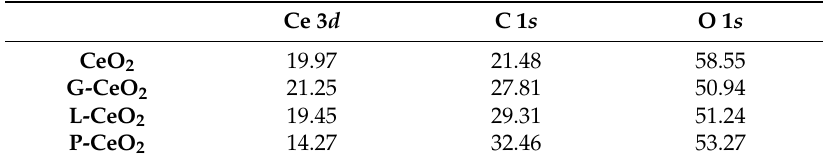
Table 1. Atomic compositions (at. %) of the Ce 3 d , C 1 s , and O 1 s core levels, collected for the uncoated and coated nCeO 2